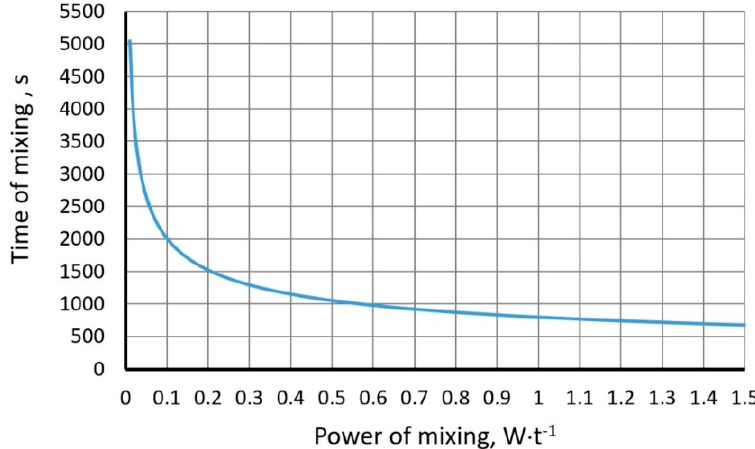
Figure 9. Mixing time as a function of mixing power (Szekly model).